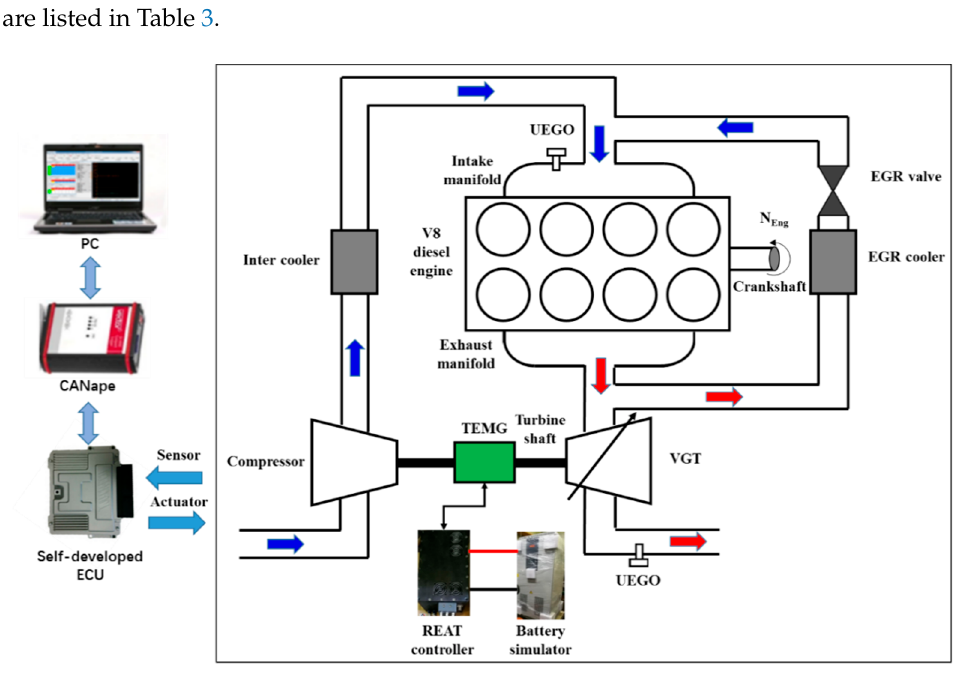
Figure 2. Schematic of experimental platform.